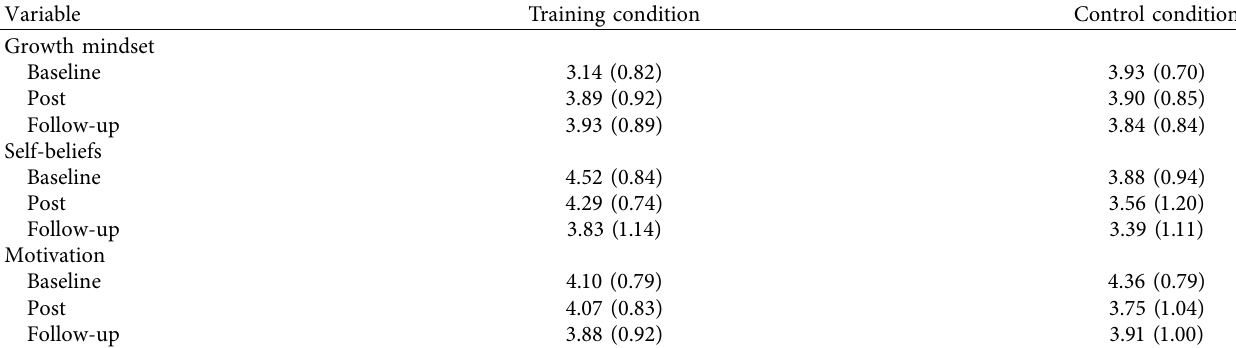
Table 6: Means (and standard deviations) of the dependent variables for both conditions.